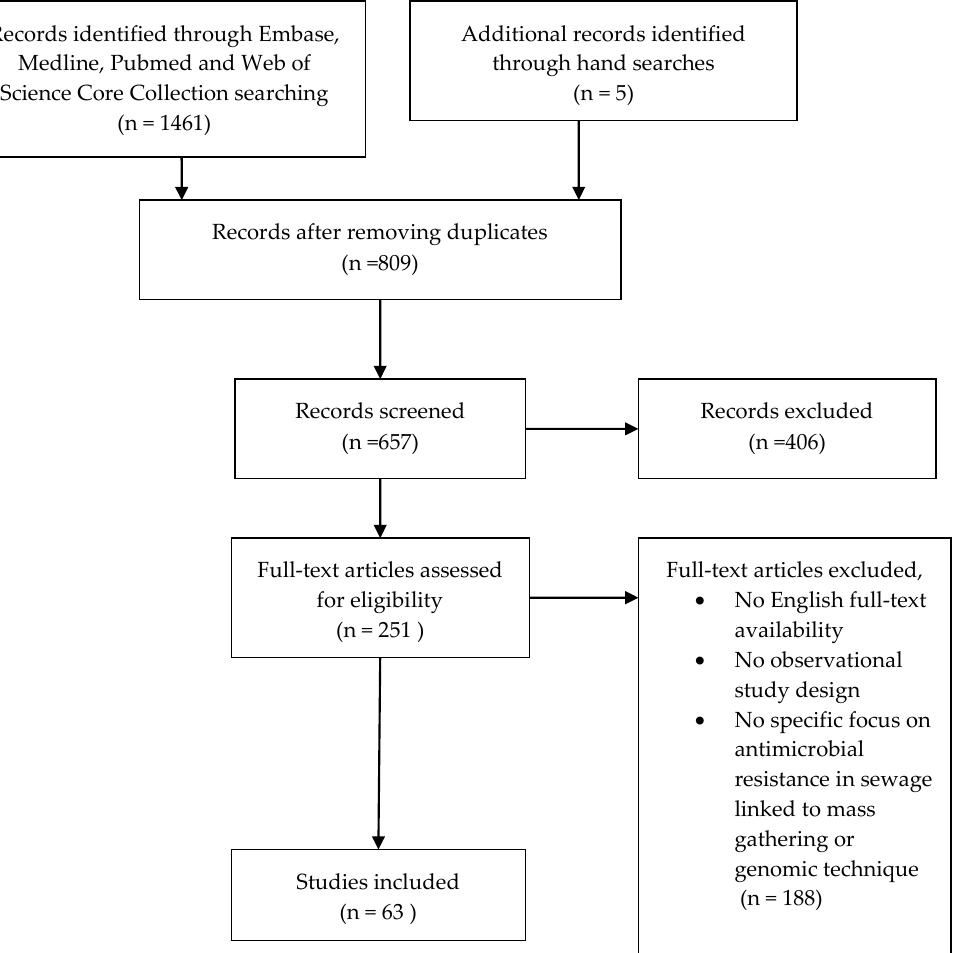
Figure 1. Flow-chart of literature